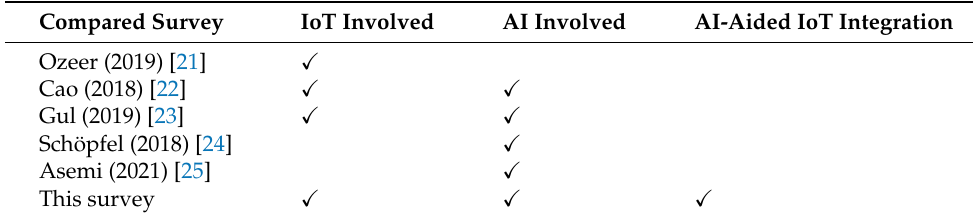
Table 1. Comparison between our and existing